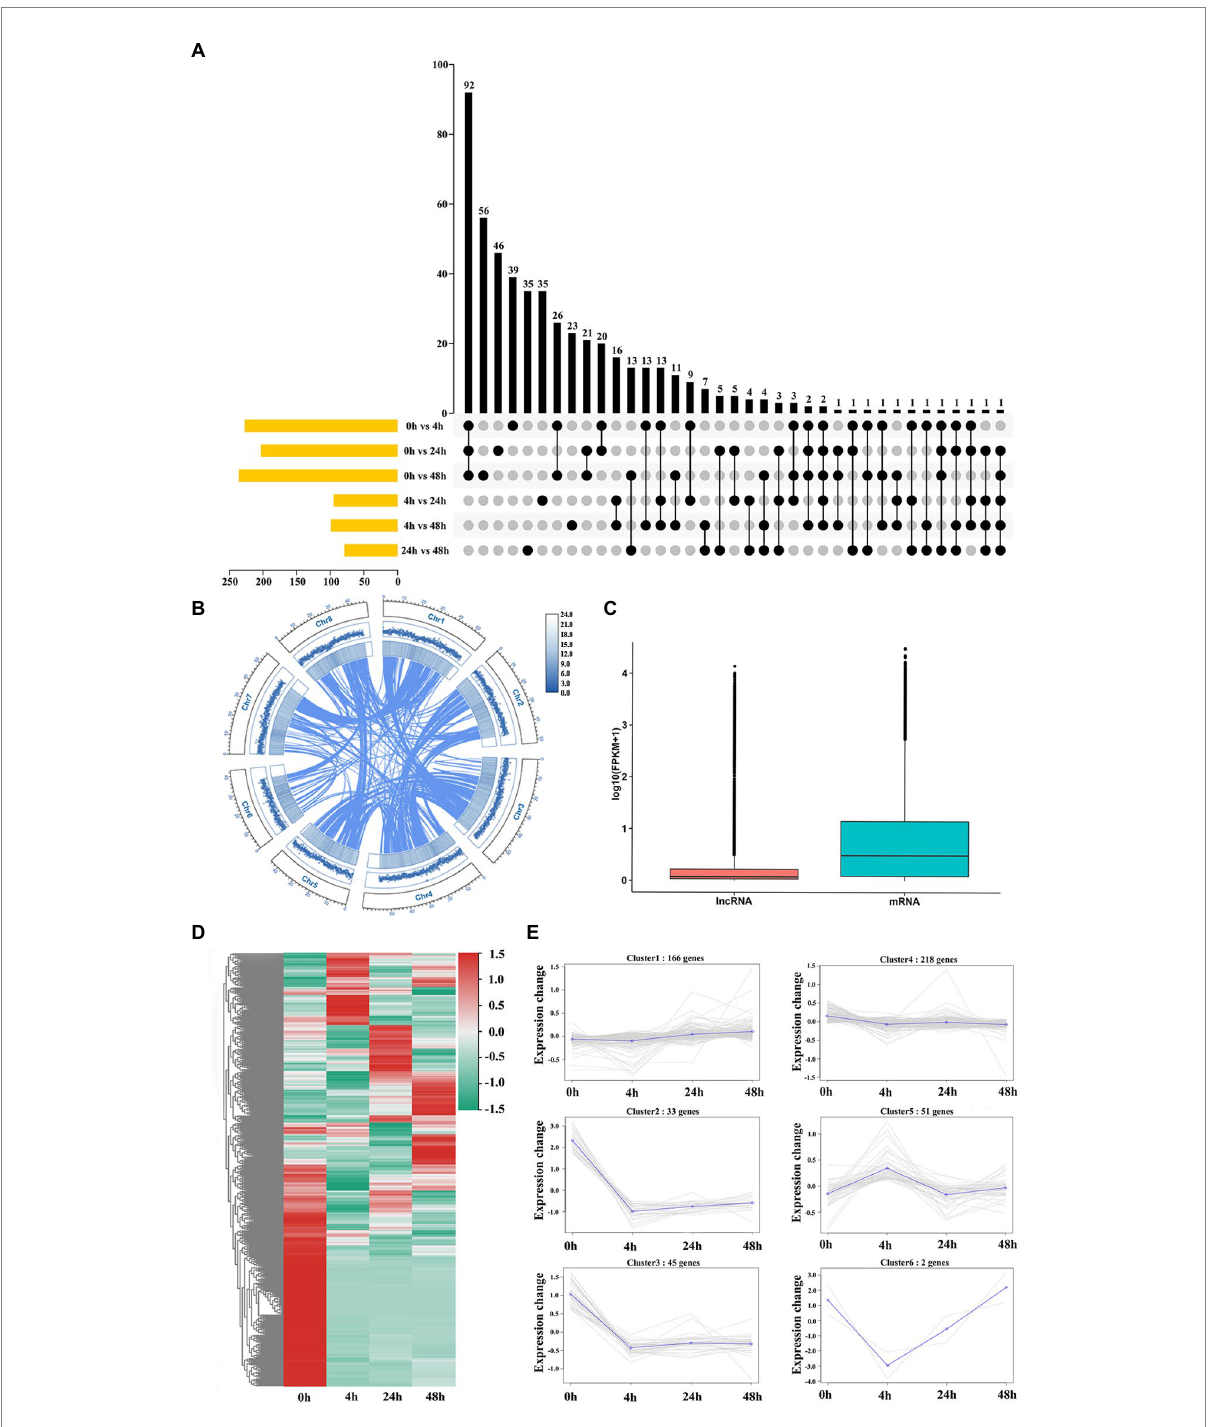
FIGURE 2 Genome-wide analysis identification and characterization of lncRNAs. (A) DElncRNA distribution in each group. (B) Circos plot of the lncRNA distribution across chromosomes. From outside to inside, lncRNA, genome feature list and linked information. (C) Expression levels of lncRNAs and mRNAs. (D) Heatmap of 515 DElncRNAs. (E) Coexpression cluster analysis of 515